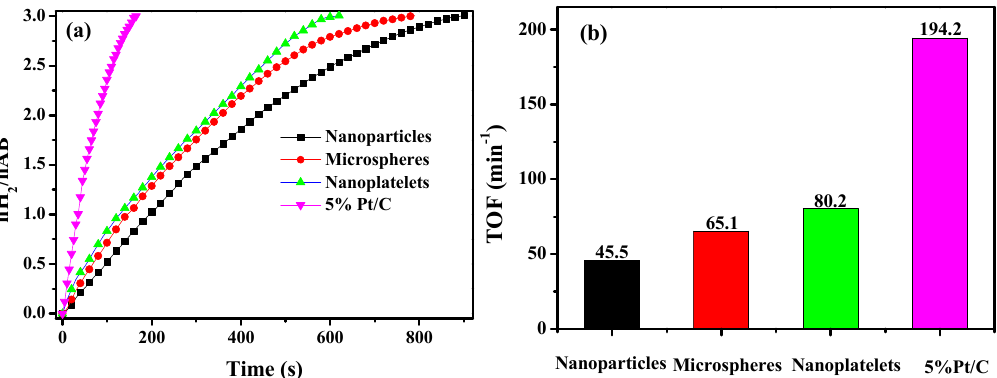
Figure 6. Hydrogen evolution from AB solution when different Ni 0.5 Cu 0.5 Co 2 O 4 nanocomposites and commercial 5% Pt/C were used ( a ) and corresponding TOF ( b ).